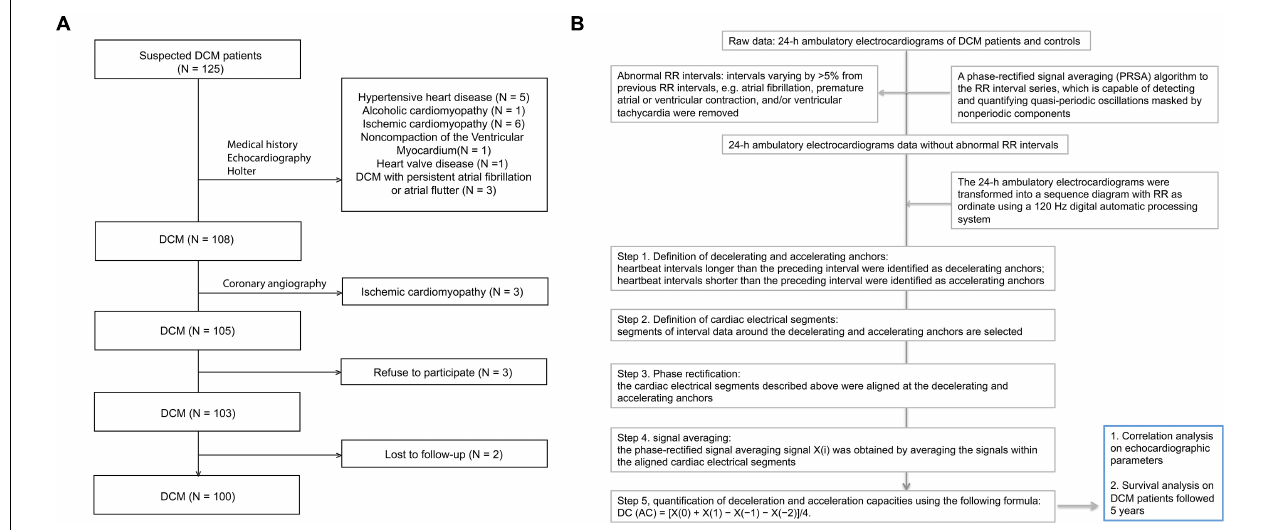
FIGURE 1 | Flowchart of patient selection and a schematic diagram of AC/DC calculation. DCM, dilated cardiomyopathy. (A) Flowchart of patient selection. (B) A schematic diagram of AC/DC